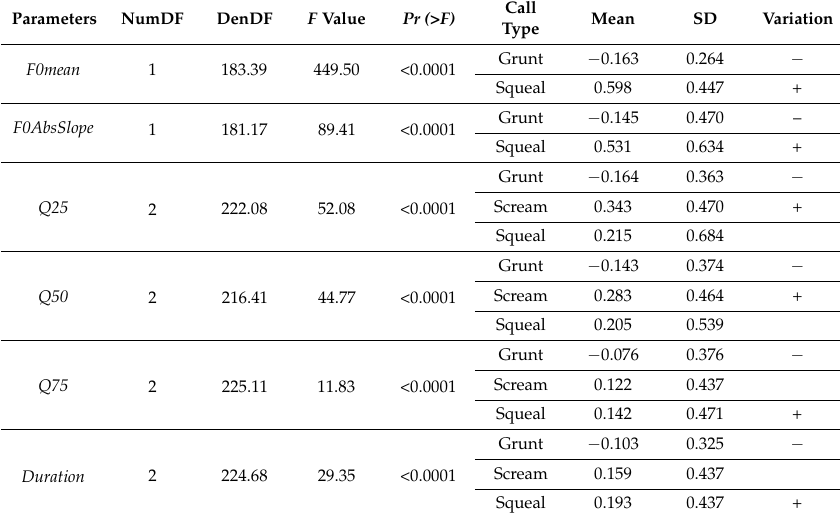
Table 6. Effect of call type on the measured acoustic parameters (only significant values are shown). Residuals of the models controlled for the following factors: sex, age, size of the group, and valence (see Supplementary Table S2 for raw values). The variation between calls is displayed as follows: + denotes the highest value; − denotes the lowest.